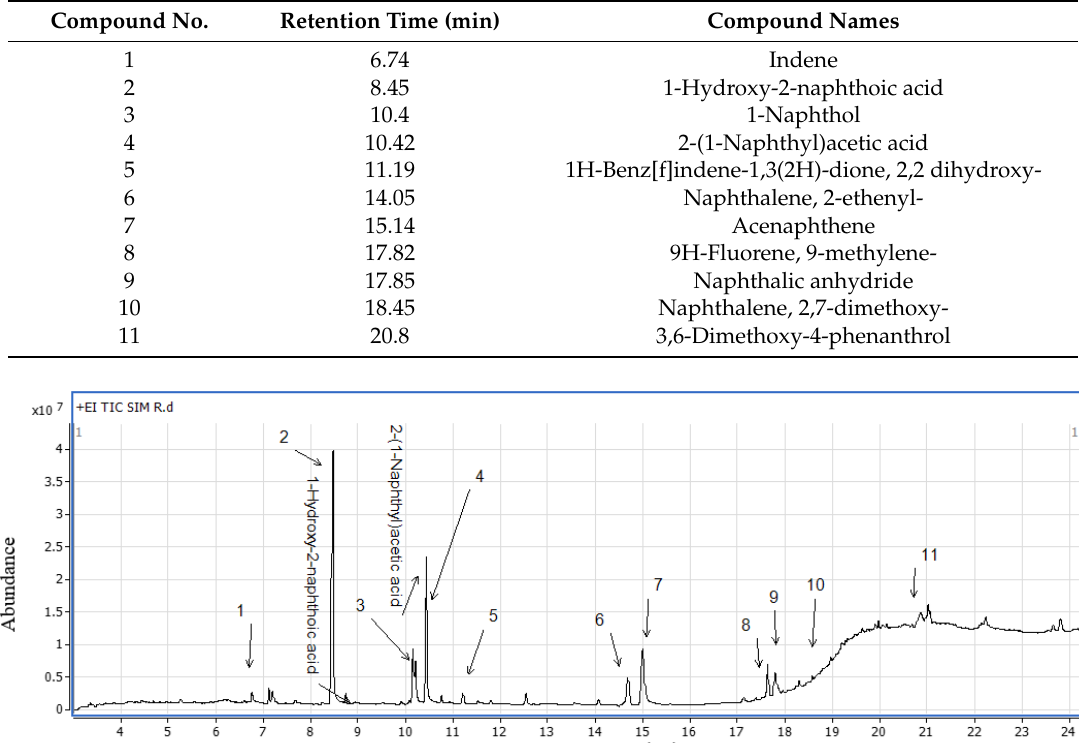
Figure 2. Chromatogram of extracted milk sample. Table 4. Assignment of different derivatives of PAHs found in most of analyzed milk and dairy-based samples.